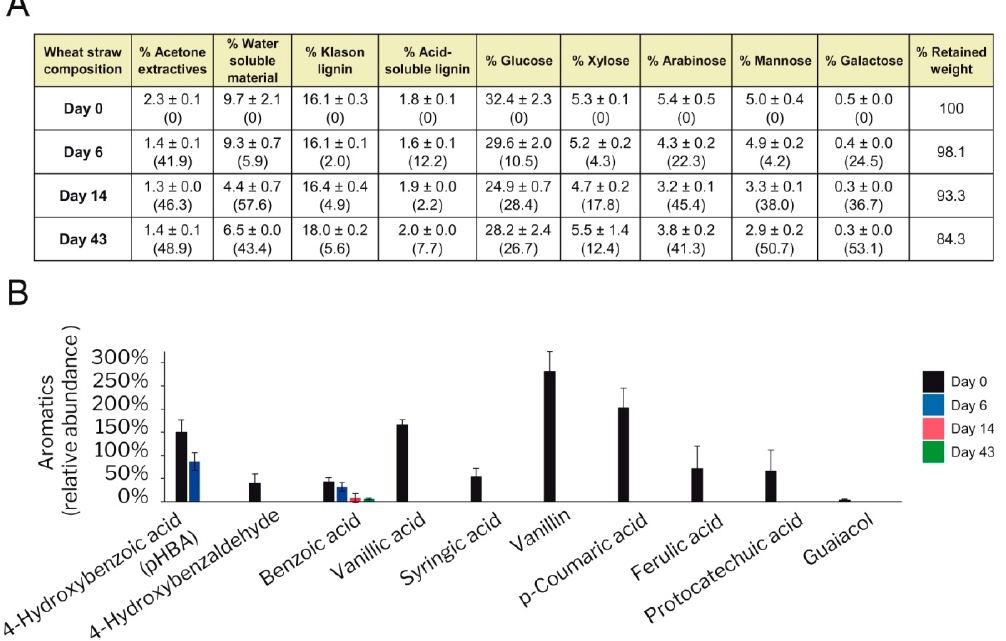
Figure 13. Degradation of wheat–straw components by P. eryngii over time. Relative abundance of: ( A ) major lignocellulose fractions (% of sample dry weight, with the degradation percentage with respect to day-0 in parentheses); and ( B ) polar aromatic compounds (vs ethylvanillin used as the internal standard at a concentration of 4 µg/g sample) in the water fraction before inoculation (Day 0, black columns) and after 6 (blue), 14 (red) and 43 (green) days of culture. Results show the average of biological triplicates and 95% confidence limits.